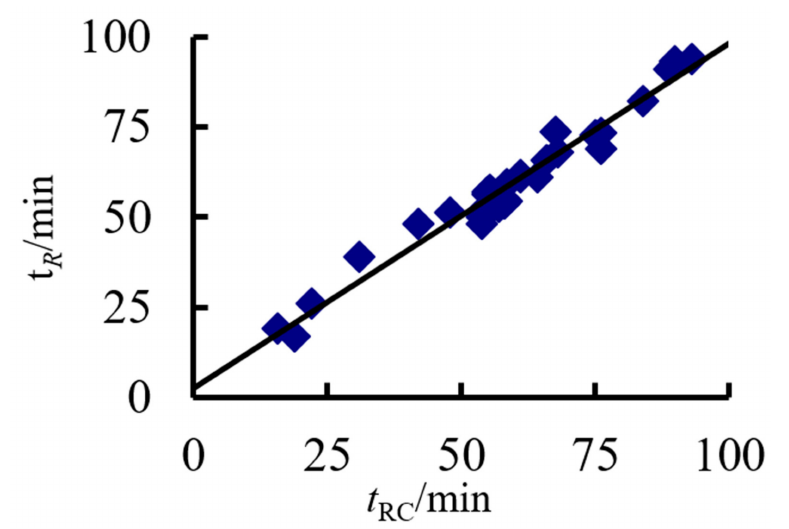
Figure 25. Comparison between the FE results and the simplified calculation